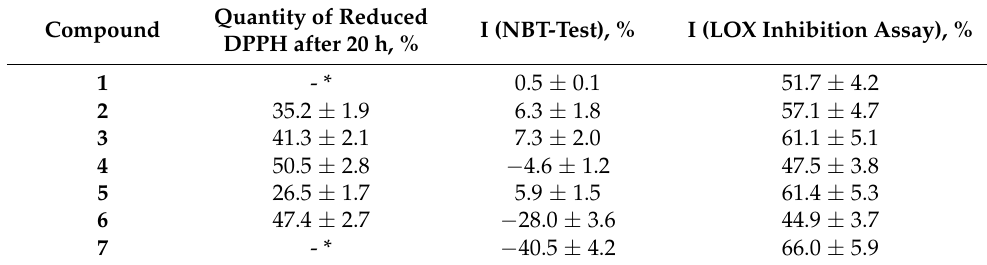
Table 1. Results of in vitro antioxidant screening.